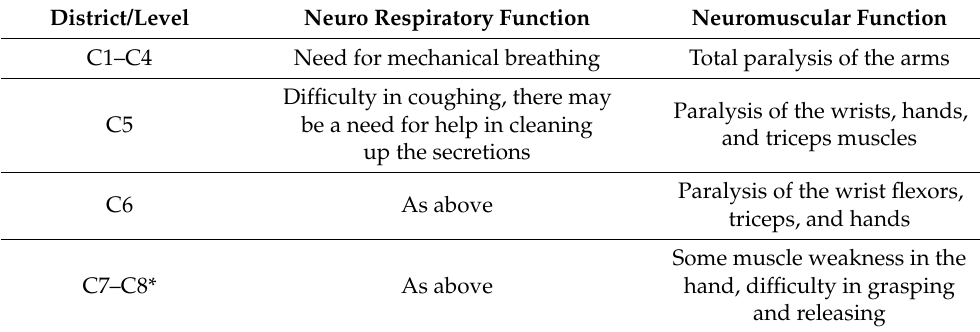
Table 1. Map between the level of the lesion and the state of neuromuscular functions in quadriplegia. District/Level Neuro Respiratory Function Neuromuscular Function C1–C4 Need for mechanical breathing Total paralysis of the arms Difficulty in coughing, there may Paralysis of the wrists, hands, C5 be a need for help in cleaning and triceps muscles up the secretions Paralysis of the wrist flexors, C6 As above triceps, and hands Some muscle weakness in the As above hand, difficulty in grasping and